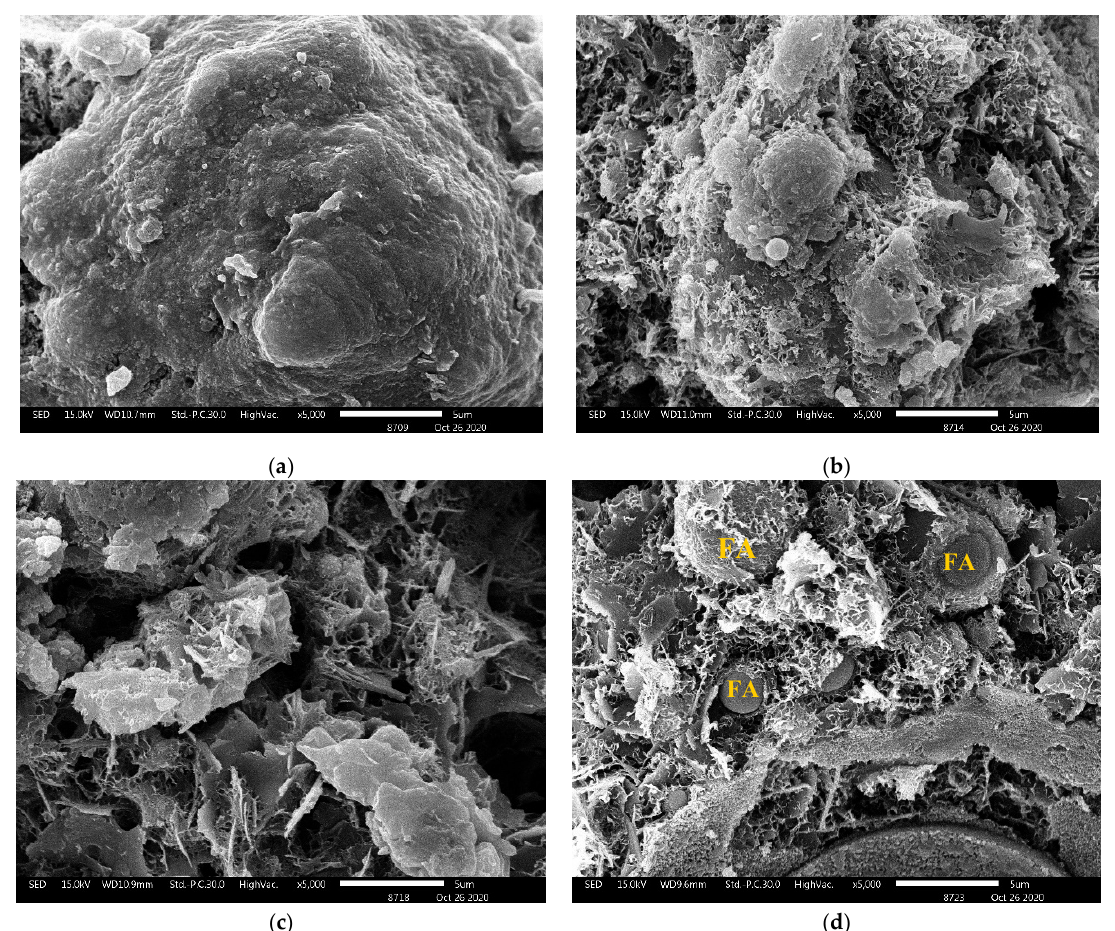
Figure 9. The SEM images of the pastes with different CAE contents in terms of ( a ) control, ( b ) CAE05, ( c ) CAE10, and ( d ) CAE20.